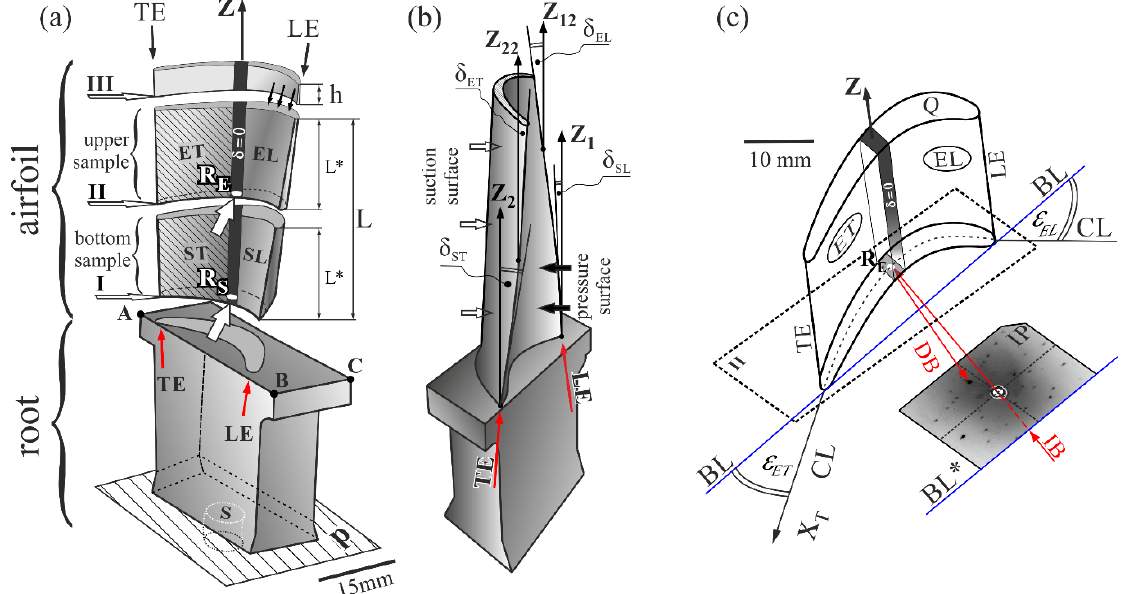
Figure 1. ( a ) Illustration of a turbine blade with a scheme of cross-sections I, II and III and the location of the ET, ST, EL and SL areas: ( b ) description of airfoil surface inclinations relative to the axis Z of a blade near the leading edge (LE) and trailing edge (TE); ( c ) a scheme for obtaining the Laue pattern for the upper sample of an airfoil with an exemplary Lauegram. CL—camber line, BL—base line of cross-section II of an airfoil, δ SL , δ EL , δ ST and δ ET —angles of inclination of LE and TE relative to the axis Z, ε EL and ε ET —angles of airfoil camber, describing the rotation of airfoil surfaces to the BL, IB—incident X-ray beam, DB—diffracted X-ray beam, IP—image plate in which the Laue pattern was obtained. Z is perpendicular to the base plane P; Z 1 , Z 12 , Z 2 and Z 12 are parallel to the Z.